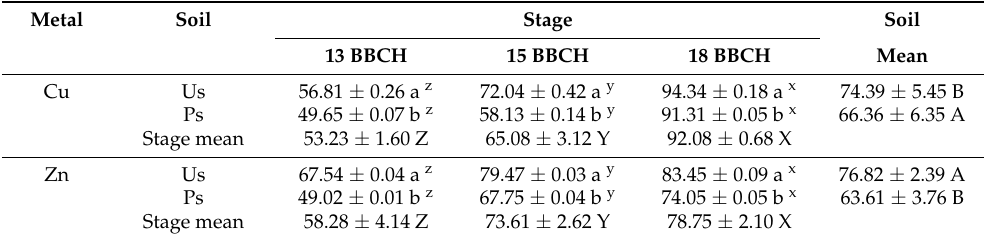
Table 9. RE of Cu and Zn in different development stages of S. perfoliatum grown in heavy metal Ps and Us.